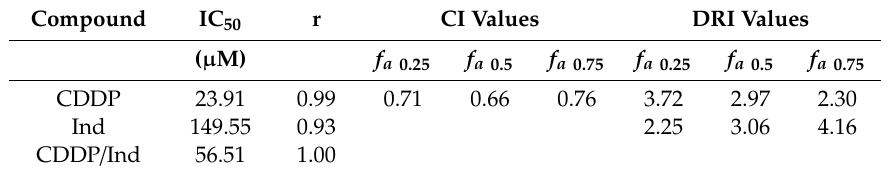
Figure 2. Effect on the viability of HeLa cells of CDDP (1–100 µM), Ind (1–200 µM), and CDDP Figure 2. E ff ect on the viability of HeLa cells of CDDP (1–100 µ M), Ind (1–200 µ M), and CDDP combined with Ind (C-I) (5/30 µM; 7.5/45 µM; 12.5/75 µM; 20/120 µM, 25/150 µM) ( a ) and plot of the combined with Ind (C-I) (5 / 30 µ M; 7.5 / 45 µ M; 12.5 / 75 µ M; 20 / 120 µ M, 25 / 150 µ M) ( a ) and plot of the combination index vs. fraction of cells affected obtained using the median-effect analysis program ( b ). combination index vs. fraction of cells a ff ected obtained using the median-e ff ect analysis program ( b ). Table 1. Dose-response association of CDDP and Ind alone or in combination. Table 1. Dose-response association of CDDP and Ind alone or in